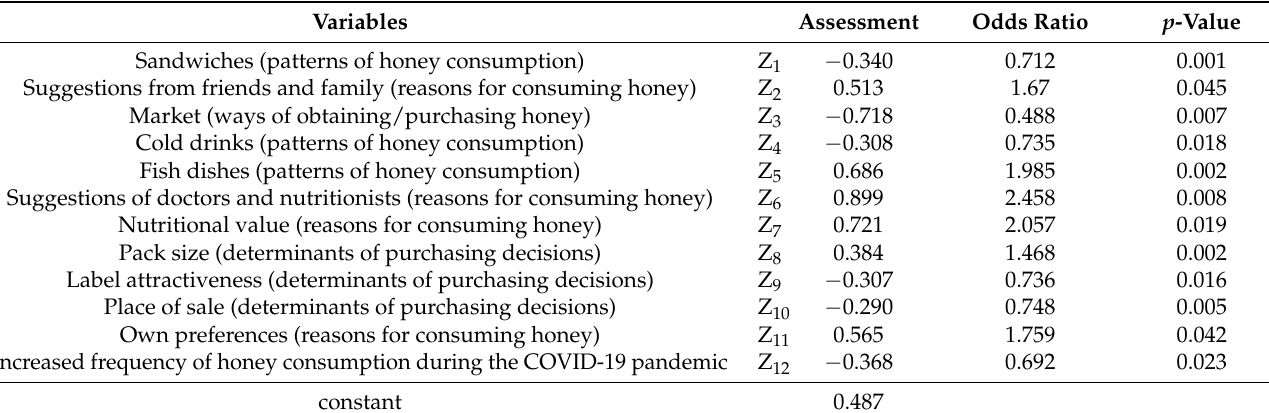
Table 7. Parameter values of the logistic regression model. Variables